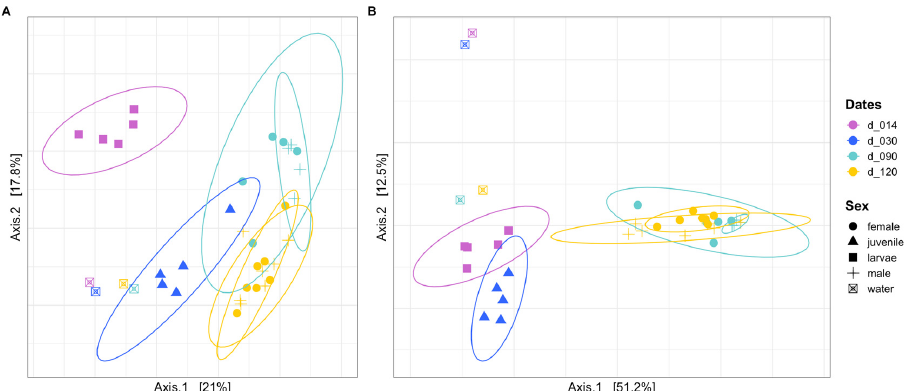
Figure 2. Principal coordinates analyses based on the unweighted ( A ) and weighted ( B ) UniFrac distances, illustrating the bacterial compositions from water and fish samples according to sampling